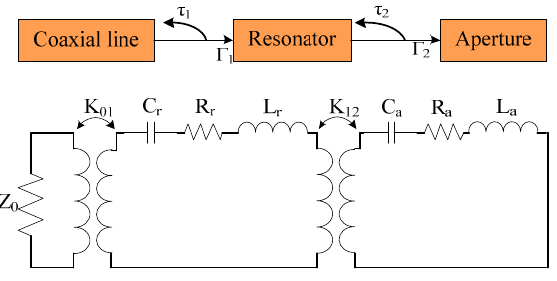
Figure 4. Equivalent circuit of the matching model.